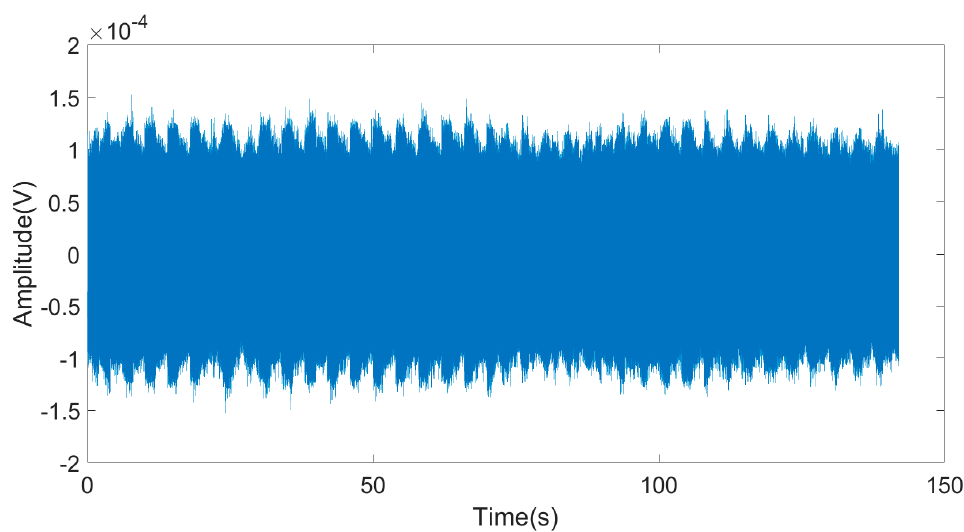
Figure 10. The raw received signal with directional antennas.